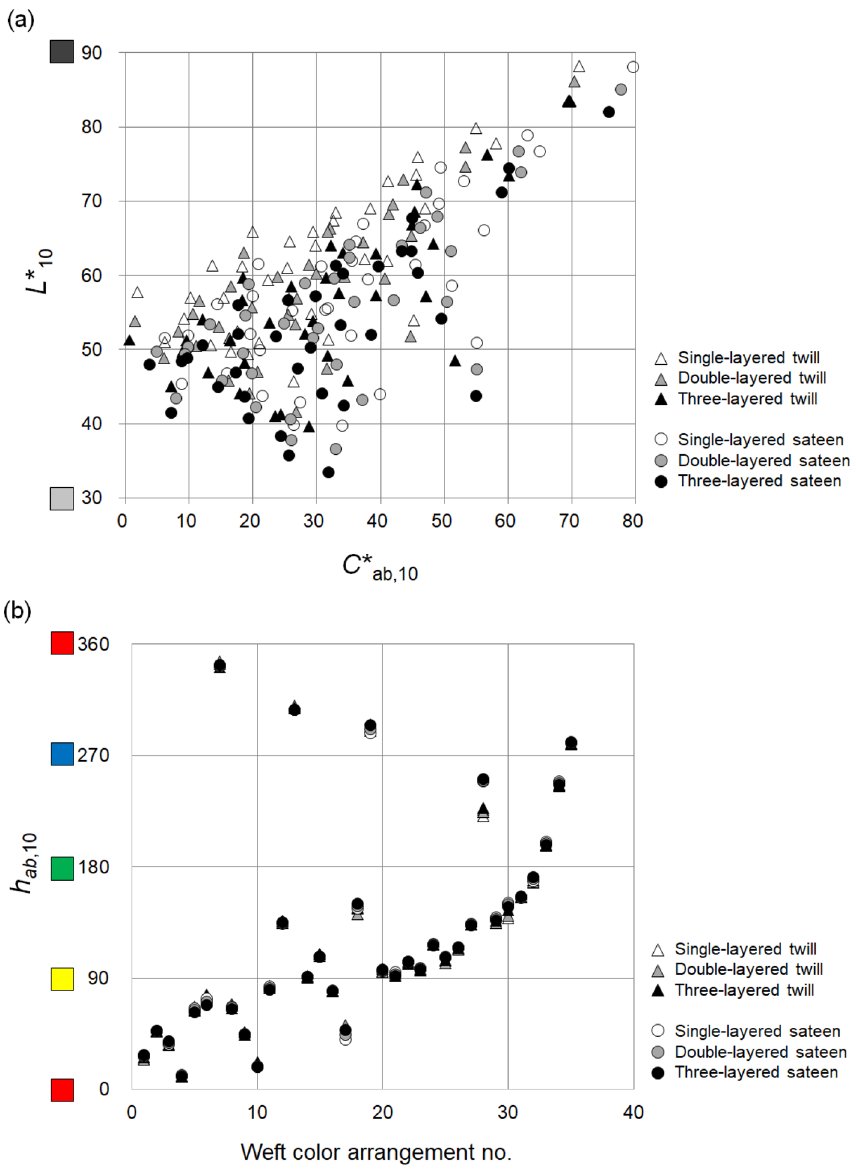
Figure 4. Distribution of single-, double-, and three-layered fabric samples in the CIELAB color space: ( a ) L * 10 C * ab,10 ; ( b ) h ab,10